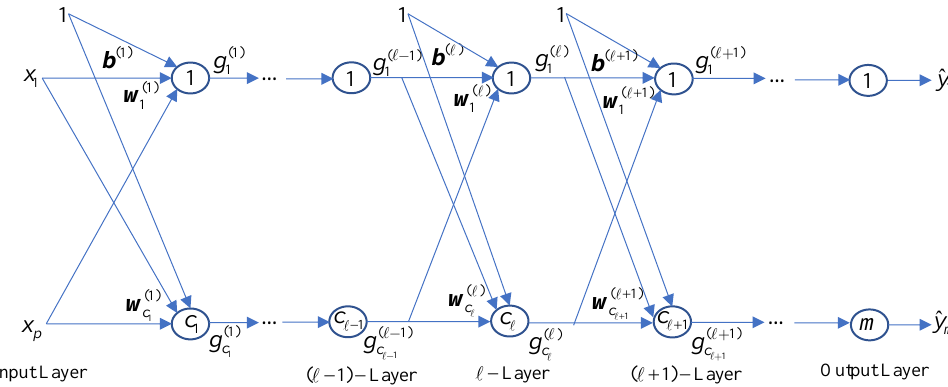
Figure 3. A possible structure of the used MLP neural network, where the (cid:96) − Layer has Hermite polynomial activation functions and it is encircled by the ( (cid:96) − 1 ) − Layer that has ReLU activation functions, and the ( (cid:96) + 1 ) − Layer that has Tanh activation functions (i.e., different structures can be obtained by changing the positions of the above types of layers).